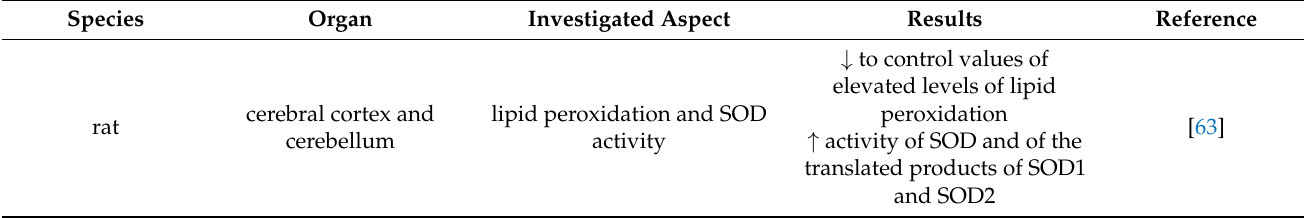
Table 4. Curcumin effects on redox status of hyperthyroid-induced animal models.